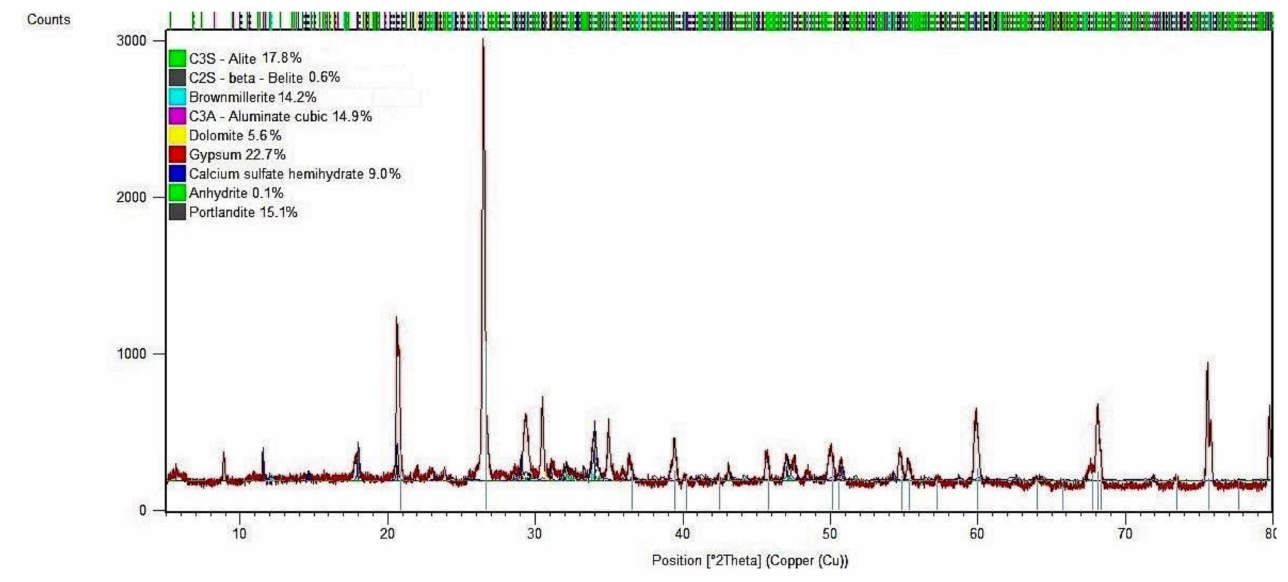
Figure 10. X-ray diffraction pattern of mortar sample with 20% SSA after 7